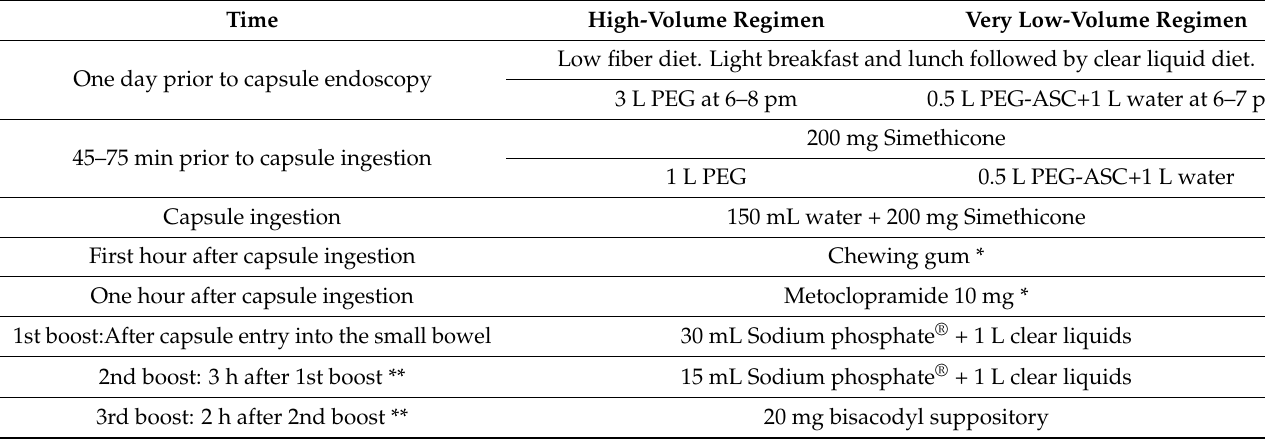
Table 1. Bowel preparation regimens. Time High-Volume Regimen Very Low-Volume Regimen Low fiber diet. Light breakfast and lunch followed by clear liquid